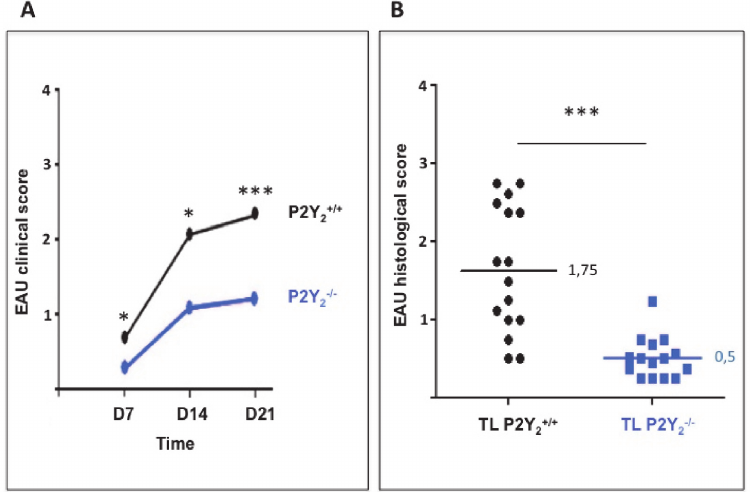
Fig 3. In vivo decreased capacity of IRBP-specific enriched TL from P2Y 2-/- mice to induce uveitis — Afferent phase. Semi-purified IRBP-specific enriched TL were recovered from five P2Y 2+/+ and P2Y 2-/- immunized mice, pooled and adoptively transferred in two groups of na ï ve C57Bl/6 mice after a 48h in vitro restimulation with IRBP. Data are from three independent experiments where 16 mice in all received P2Y 2+/+ TL and 15 mice P2Y 2-/- TL. (A) A blind fundoscopy was performed at days 7, 14 and 21 and a clinical score was established for each eye of every animal in the two groups. Data represent the median of clinical scores established for all mice at each time point. (B) At day 21, all the mice were sacrificed, the eyes enucleated and processed for histology. Hematoxylin-eosine coloration was realized in order to performed a double blind histological grading. Each symbol represents the established histological score for one mouse. Lines represent median histological scores. * p < 0,05; *** p < 0,001.